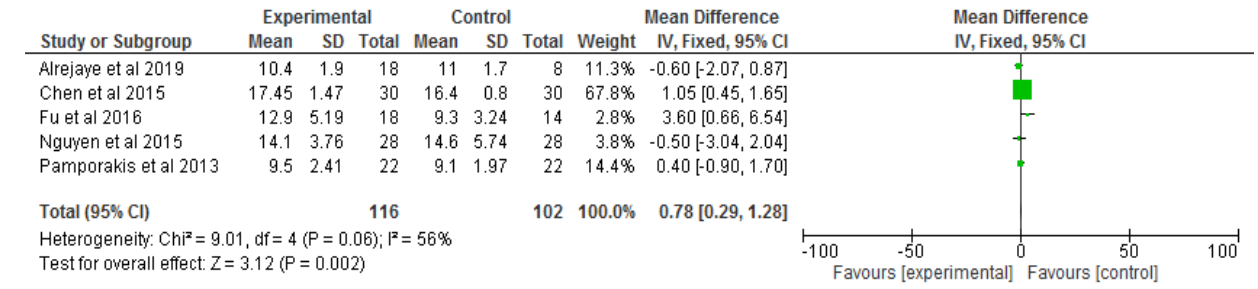
Figure 2. Forest plot for expansion with protraction between experiment and control.